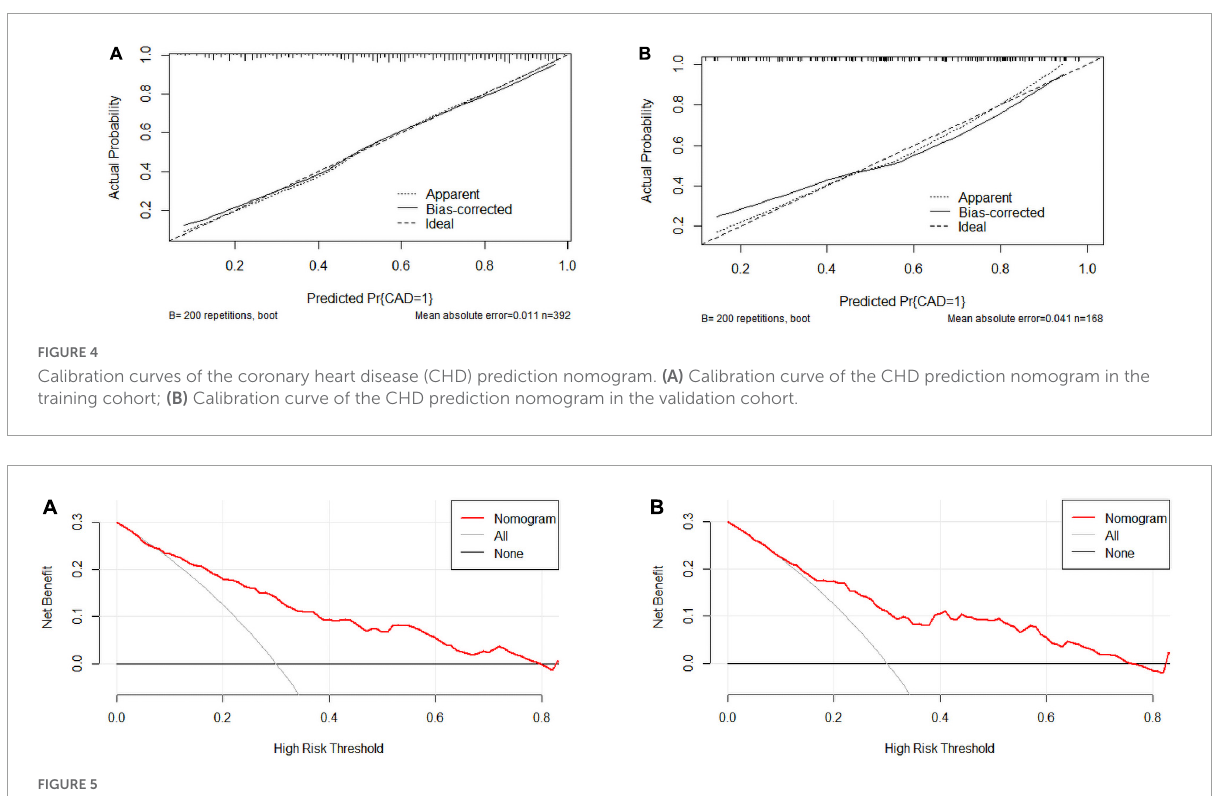
trial revealed that patients with LDL-C up to 65.2 mg/dL (1.62 mmol/L) and Lp(a) > 50 mg/dL had a 90%